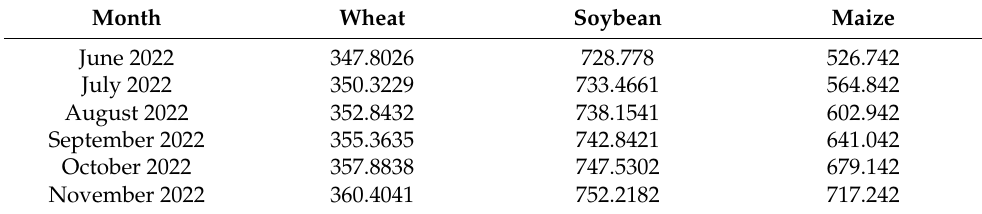
Table 3. Forecasting of world wheat, soybean, and maize prices (USD per metric ton).